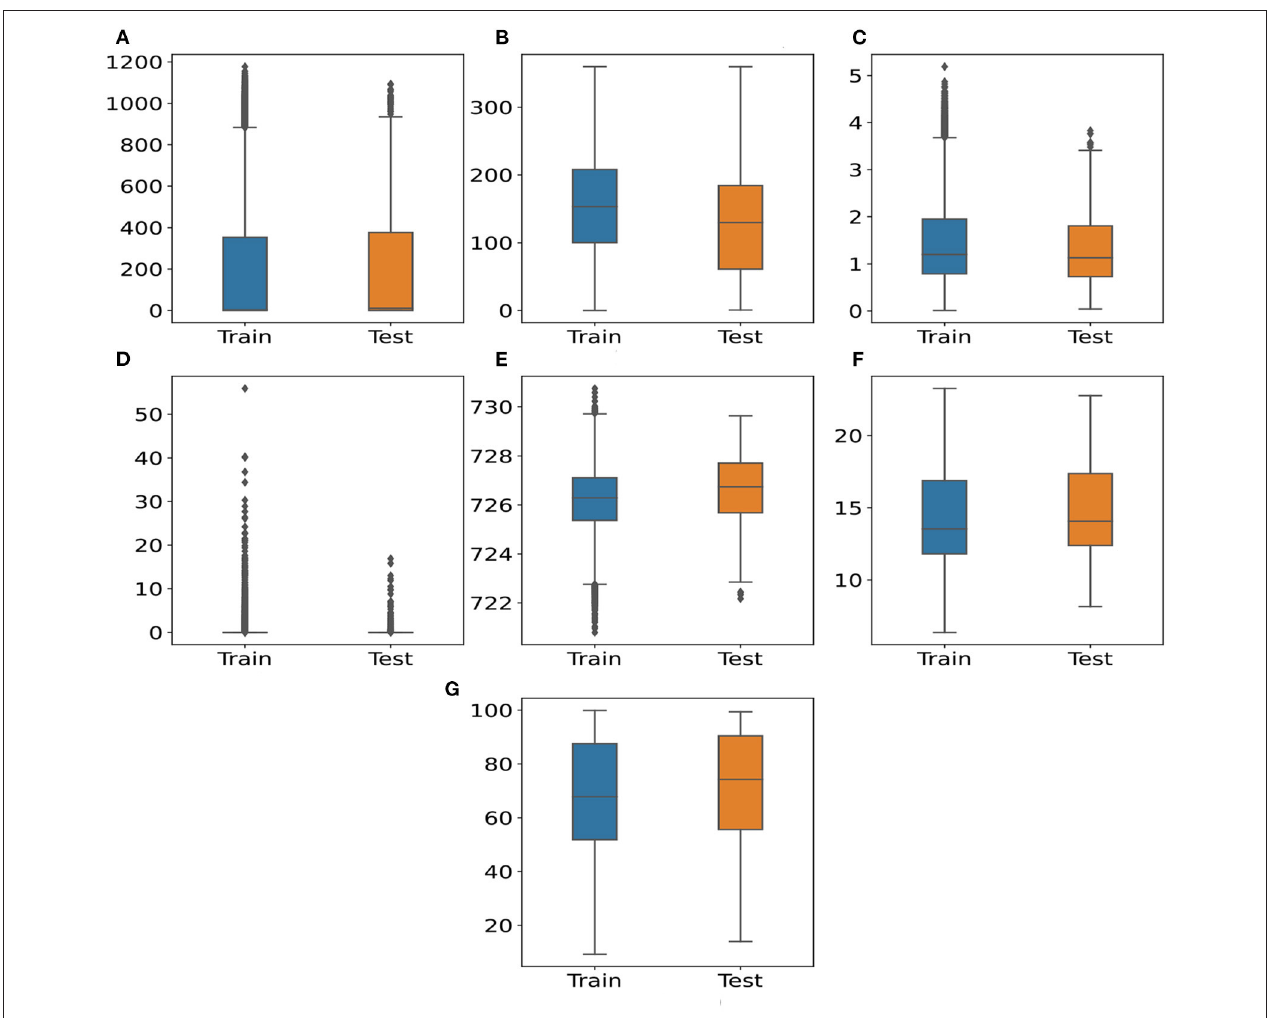
FIGURE 1 | Distributions of meteorological features between training and testing set. (A) SR (W/m 2 ) (B) WD ( ◦ ) (C) WS (m/s) (D) Prec (mm) (E) p (mb) (F) temperature ( ◦ C) (G) RH (%).